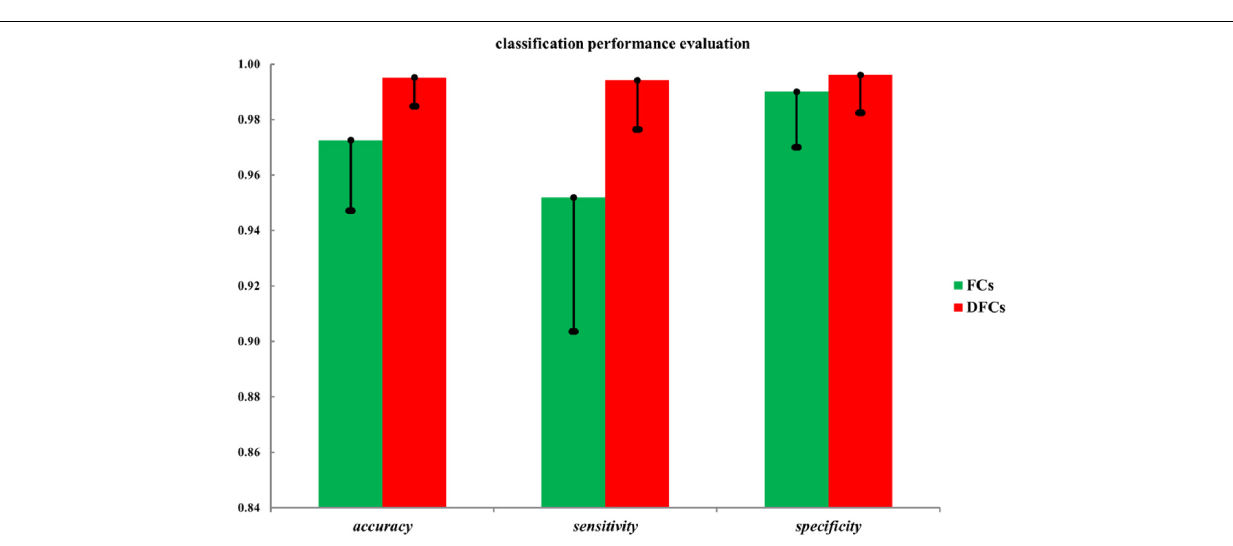
Frontiers in Human Neuroscience |